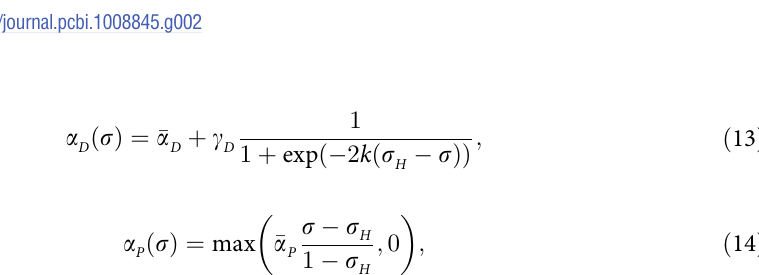
Fig 2. Schematic illustration of phenotypic transitions and geometric cell description. In the ABM, the geometry of the cell is approximated by a circle, where each agent stores the position of the cell ( x ), nucleus radius ( R ( R ), and action radius R A . The cell radius is selected such that the area of the agent ( A ) is the same as the average cell area. The transitions between cell phenotypes can be deterministic (black arrows) or stochastic (red arrows). The transitions from quiescent cells ( Q ) are controlled by the intensity functions α P and α D , which govern the transition to proliferative ( P ) and dead ( D ) cells, respectively. These transitions probabilities are proportional to the glucose concentration, σ . After a quiescent cell transition to the proliferative phenotype, the cells split into two cells with half of the original area after time interval τ P − τ G 1 , where τ P is the duration of the cell cycle, and τ G 1 is the duration of the growth phase G1. This time interval includes the S and G2 phases of cell cycle. The adhesion and repulsion forces act on these new cells (blue arrows) to maintain the distance between them. The new cells enter the growth phase, reaching the same area as the original cell, and then return to the quiescent